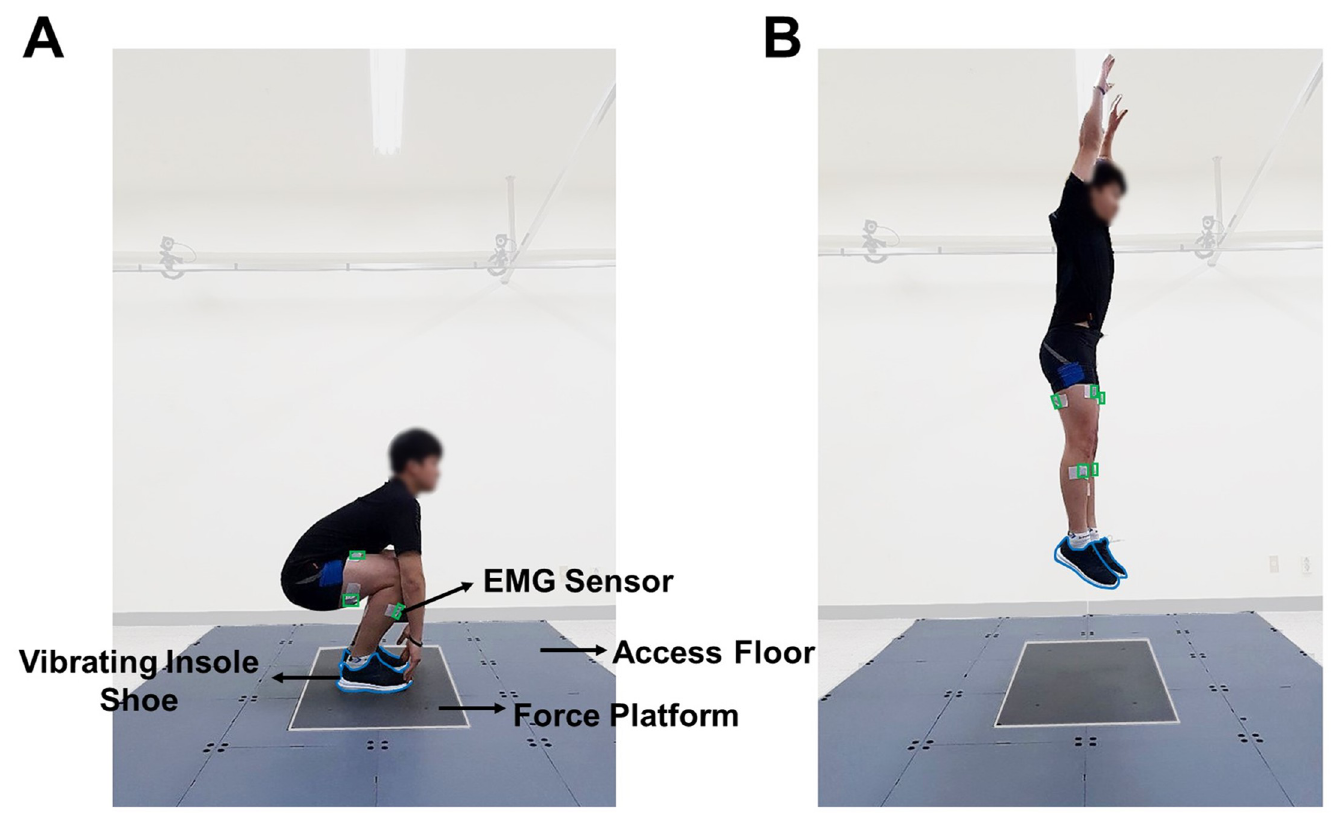
Fig 2. Demonstration of the vertical jump task. (A) The initial position of the participant on the force platform before the jump. Placing their feet shoulder-width apart, participants bent their knees and lowered their bodies so that their fingers touched the toe section of the shoes. (B) The highest position after the experimenter gave the participants a verbal signal to jump. The participants jumped as high as possible, extending their arms upward. Eight non-invasive EMG sensors were used to measure the muscle activation levels of the tibialis anterior, gastrocnemius medialis, rectus femoris, and biceps femoris of both the legs. The placement sites of the EMG sensors, the vibrating shoe, and the force platform are highlighted in green, blue, and light gray colors, respectively.